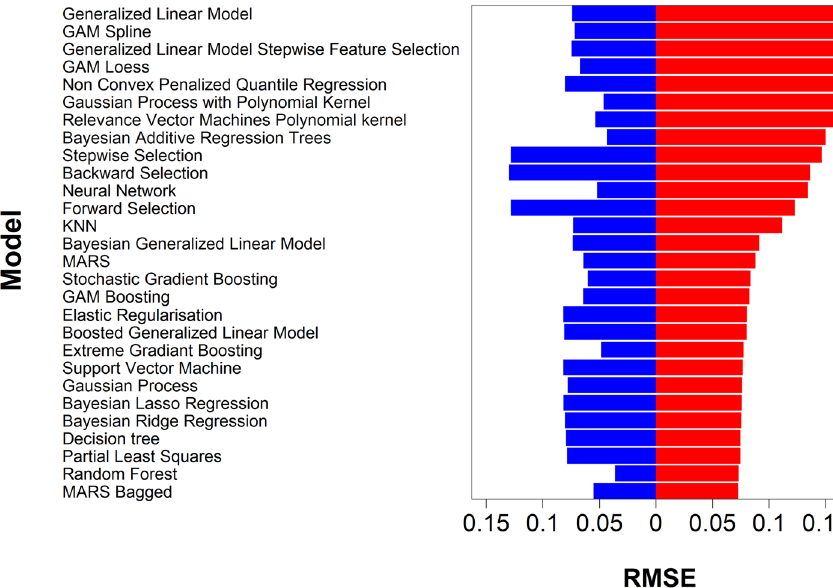
Figure 2. Comparison of the different performance of the tested algorithms on the train (blue) and test set (red).